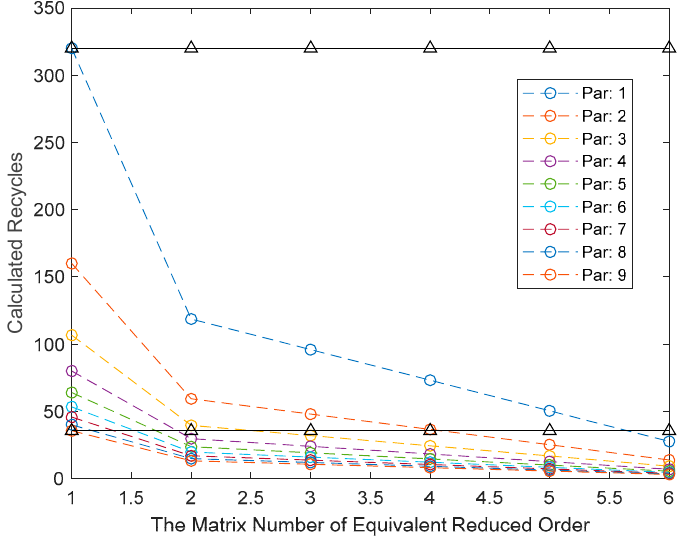
Figure 7. Comparison of computational performance between the proposed method and previous parallel algorithms [16].